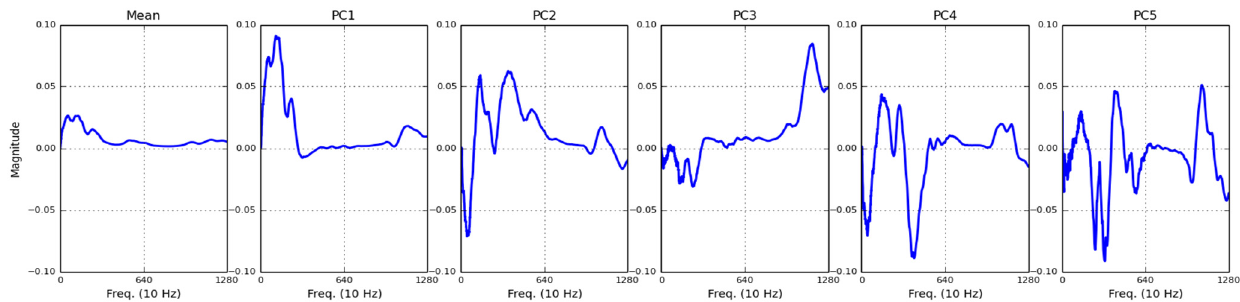
Figure 4. The mean and the first five PCs of the spectrogram of learning instance Bearing1-1 (Note: the horizontal axis has a unit of 10 Hz per tick